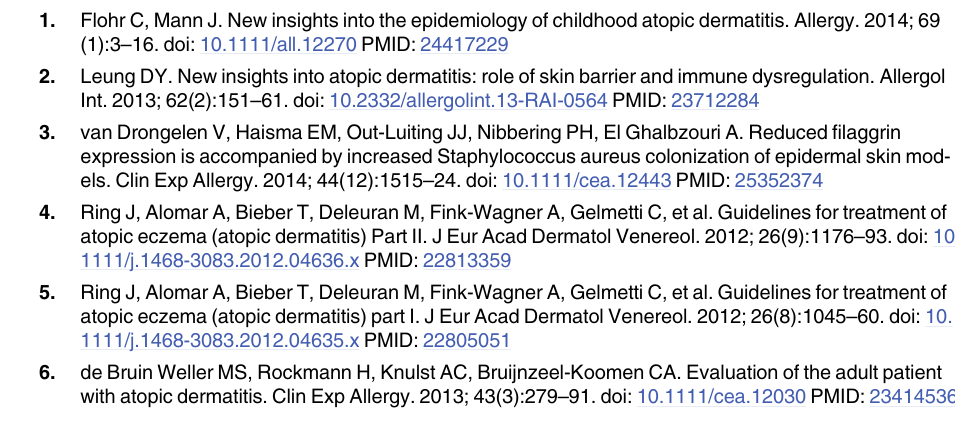
S2 Table. Mixed effects model comparing time trends between chitosan and placebo groups. SD-standard